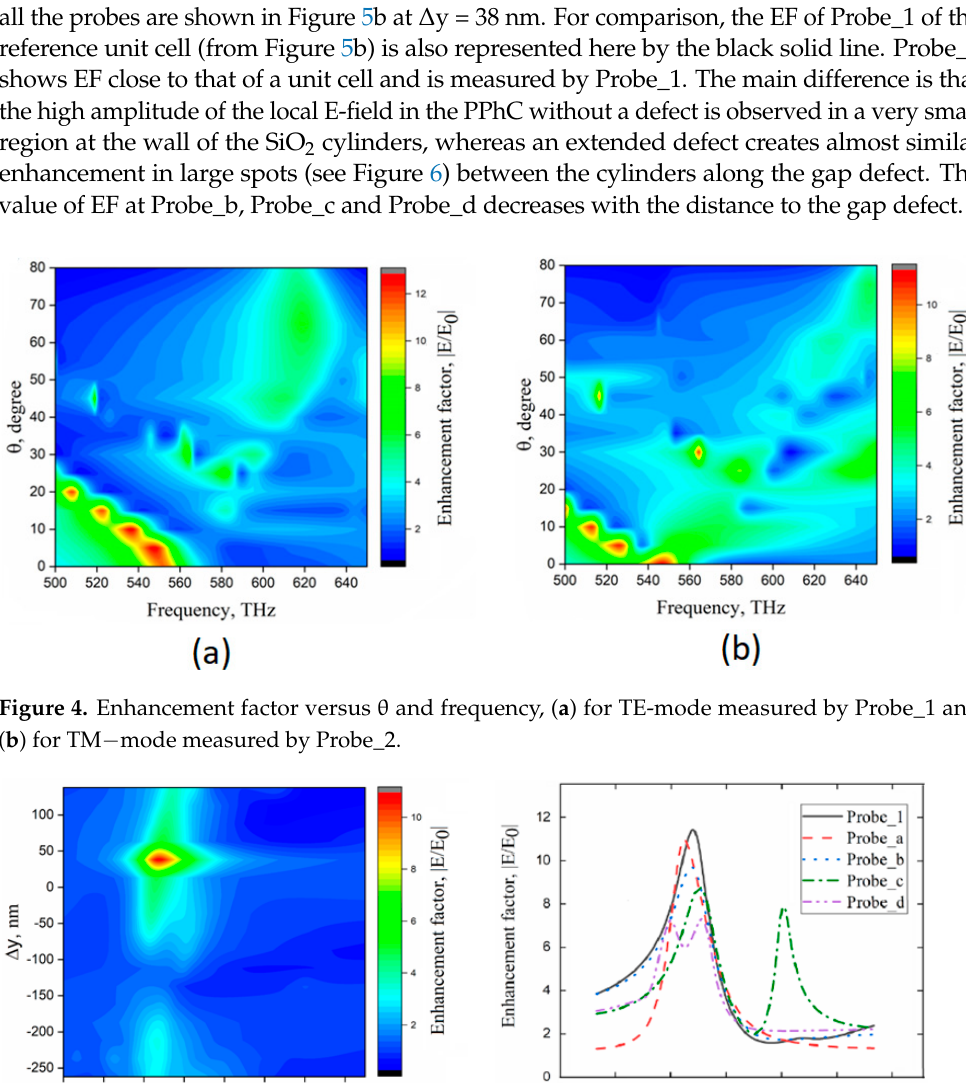
Figure 4. Enhancement factor versus θ and frequency, ( a ) for TE-mode measured by Probe_1 and ( b ) for TM − mode measured by Probe_2.